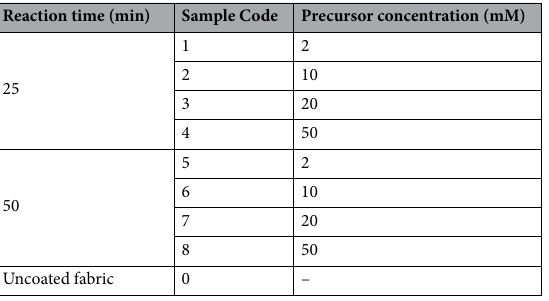
Table 1. Different precursor concentrations and reaction times used for coating